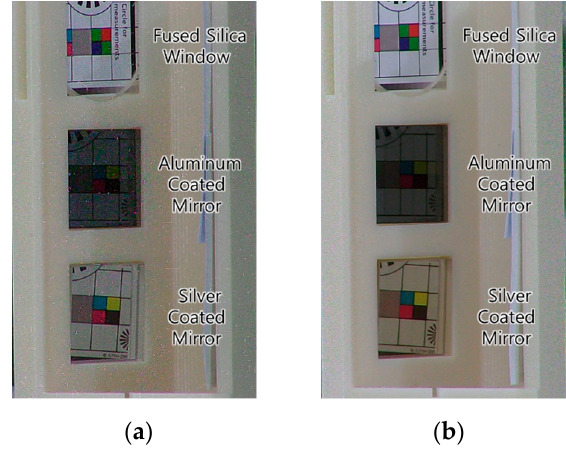
Figure 8. Optical Parts: ( a ) Initial State; ( b ) Final State. Table 1. Light Transmittance for Window and Light Reflectance for